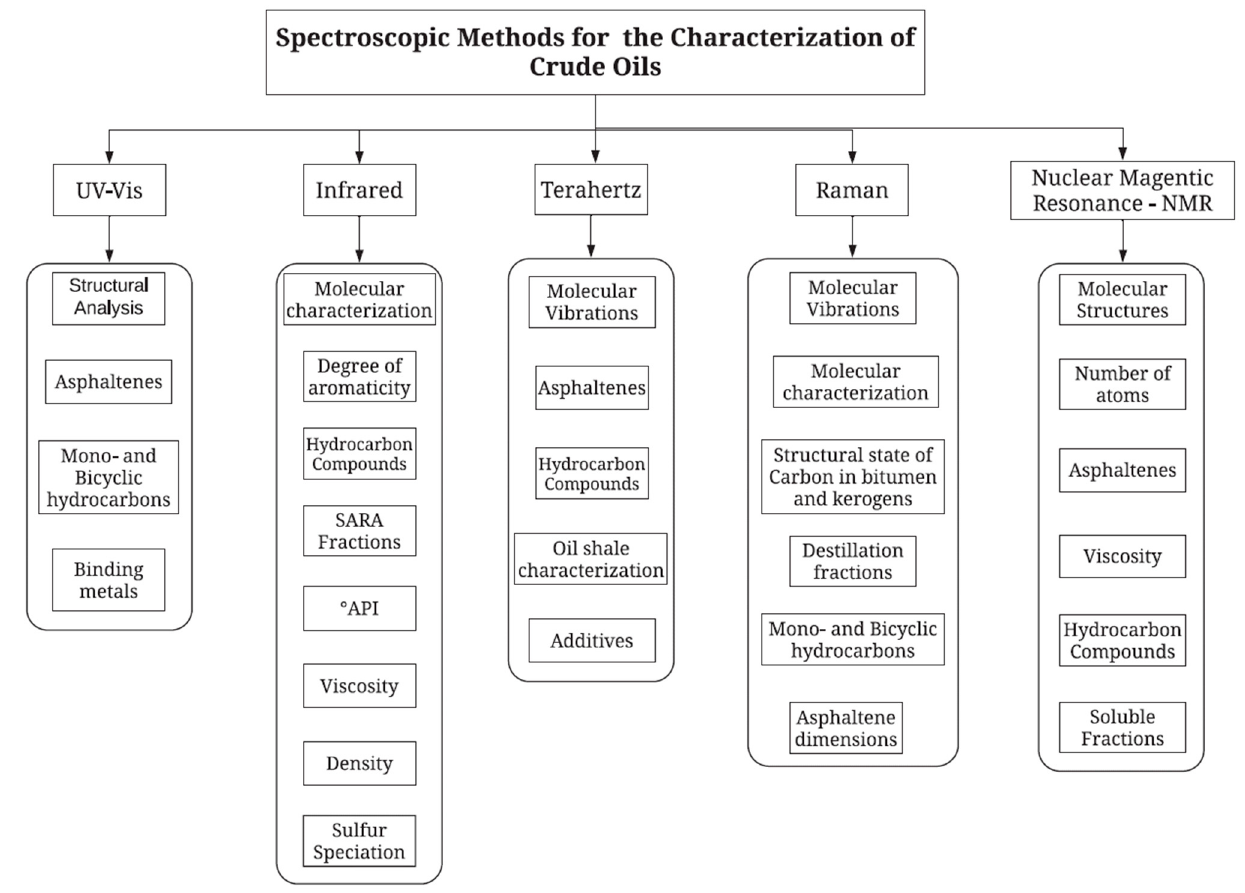
Figure 8. Spectroscopic methods for petroleum properties assay. (Adapted with permission from Ref. [164] Copyright 2019, copyright Elsevier).